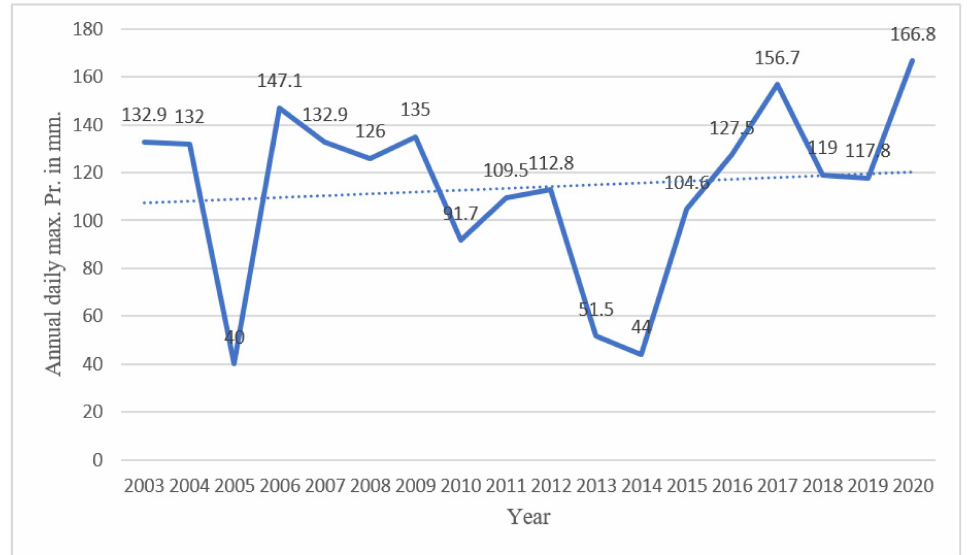
Figure A7. Observed annual daily maximum precipitation of Khudi Bazar, Lamjung.